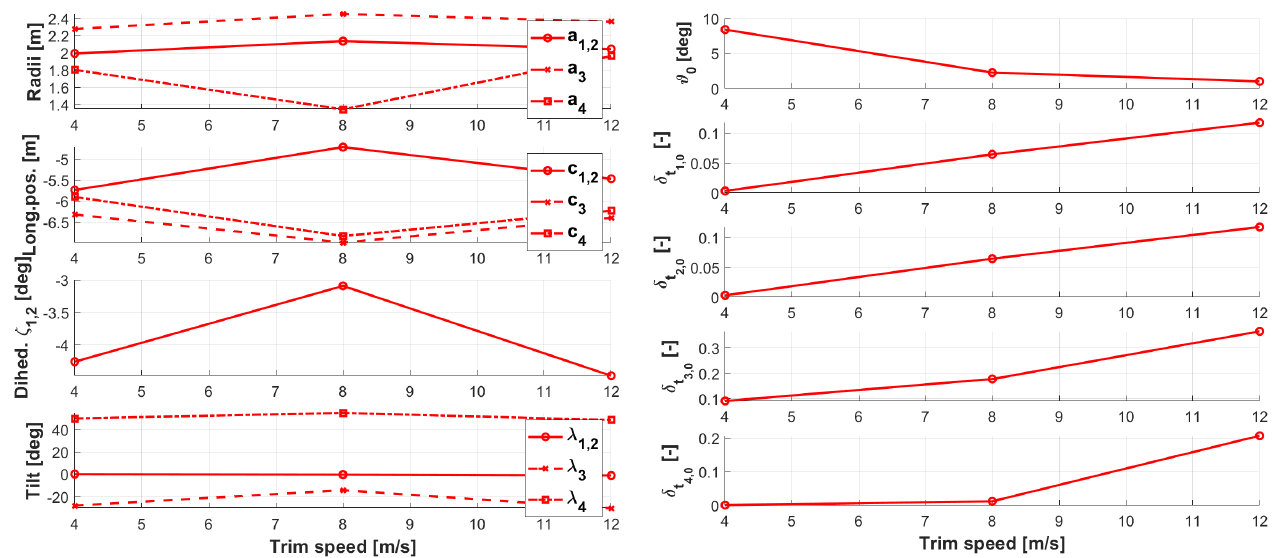
Figure 11. Optimal solutions ( left ) and trim results for optimizations at different airspeeds on layout